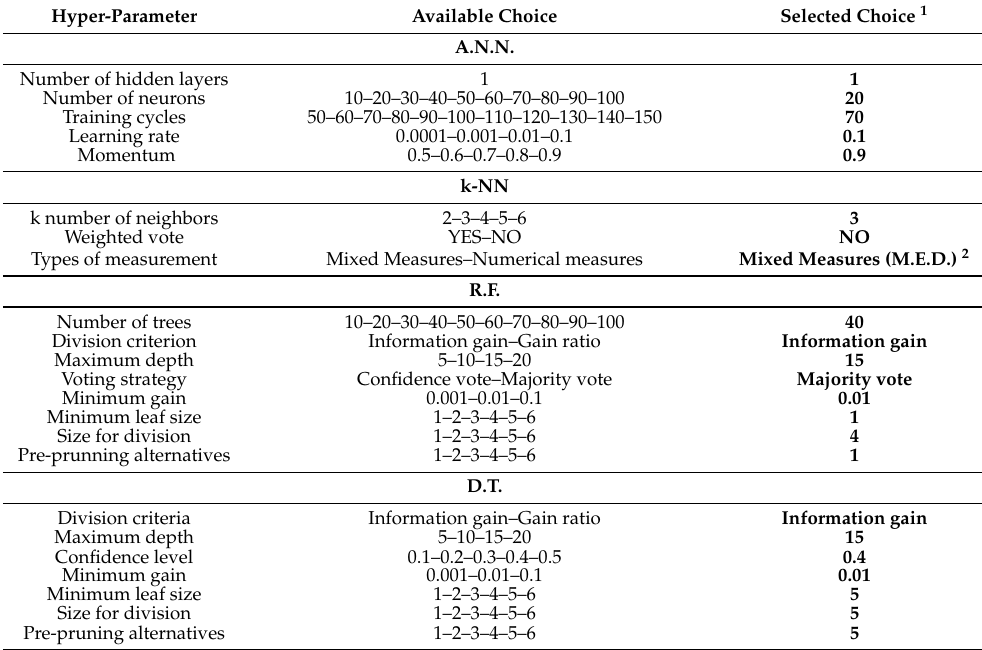
Table 5. Hyper-parameter testing and selection of optimal values for parametric and non- parametric models.